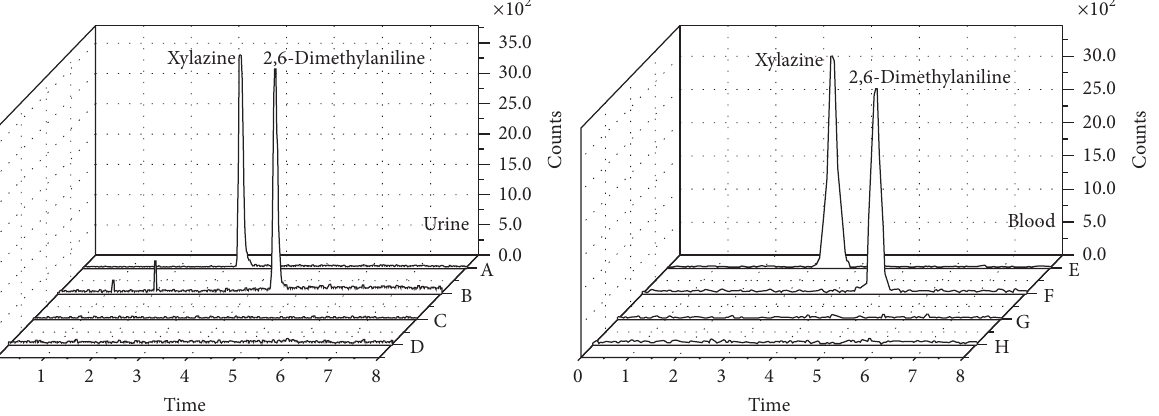
Figure 5: Representative MRM chromatograms: (A) blank urine spiked with xylazine (100ng/mL); (B) blank urine spiked with DMA (100ng/mL); (C) blank urine for xylazine; (D) blank urine for 2,6-dimethylaniline; (E) blank blood spiked with xylazine (100ng/mL); (F) blank blood spiked with DMA (100 ng/mL); (G) blank blood for xylazine; (H) blank urine blood